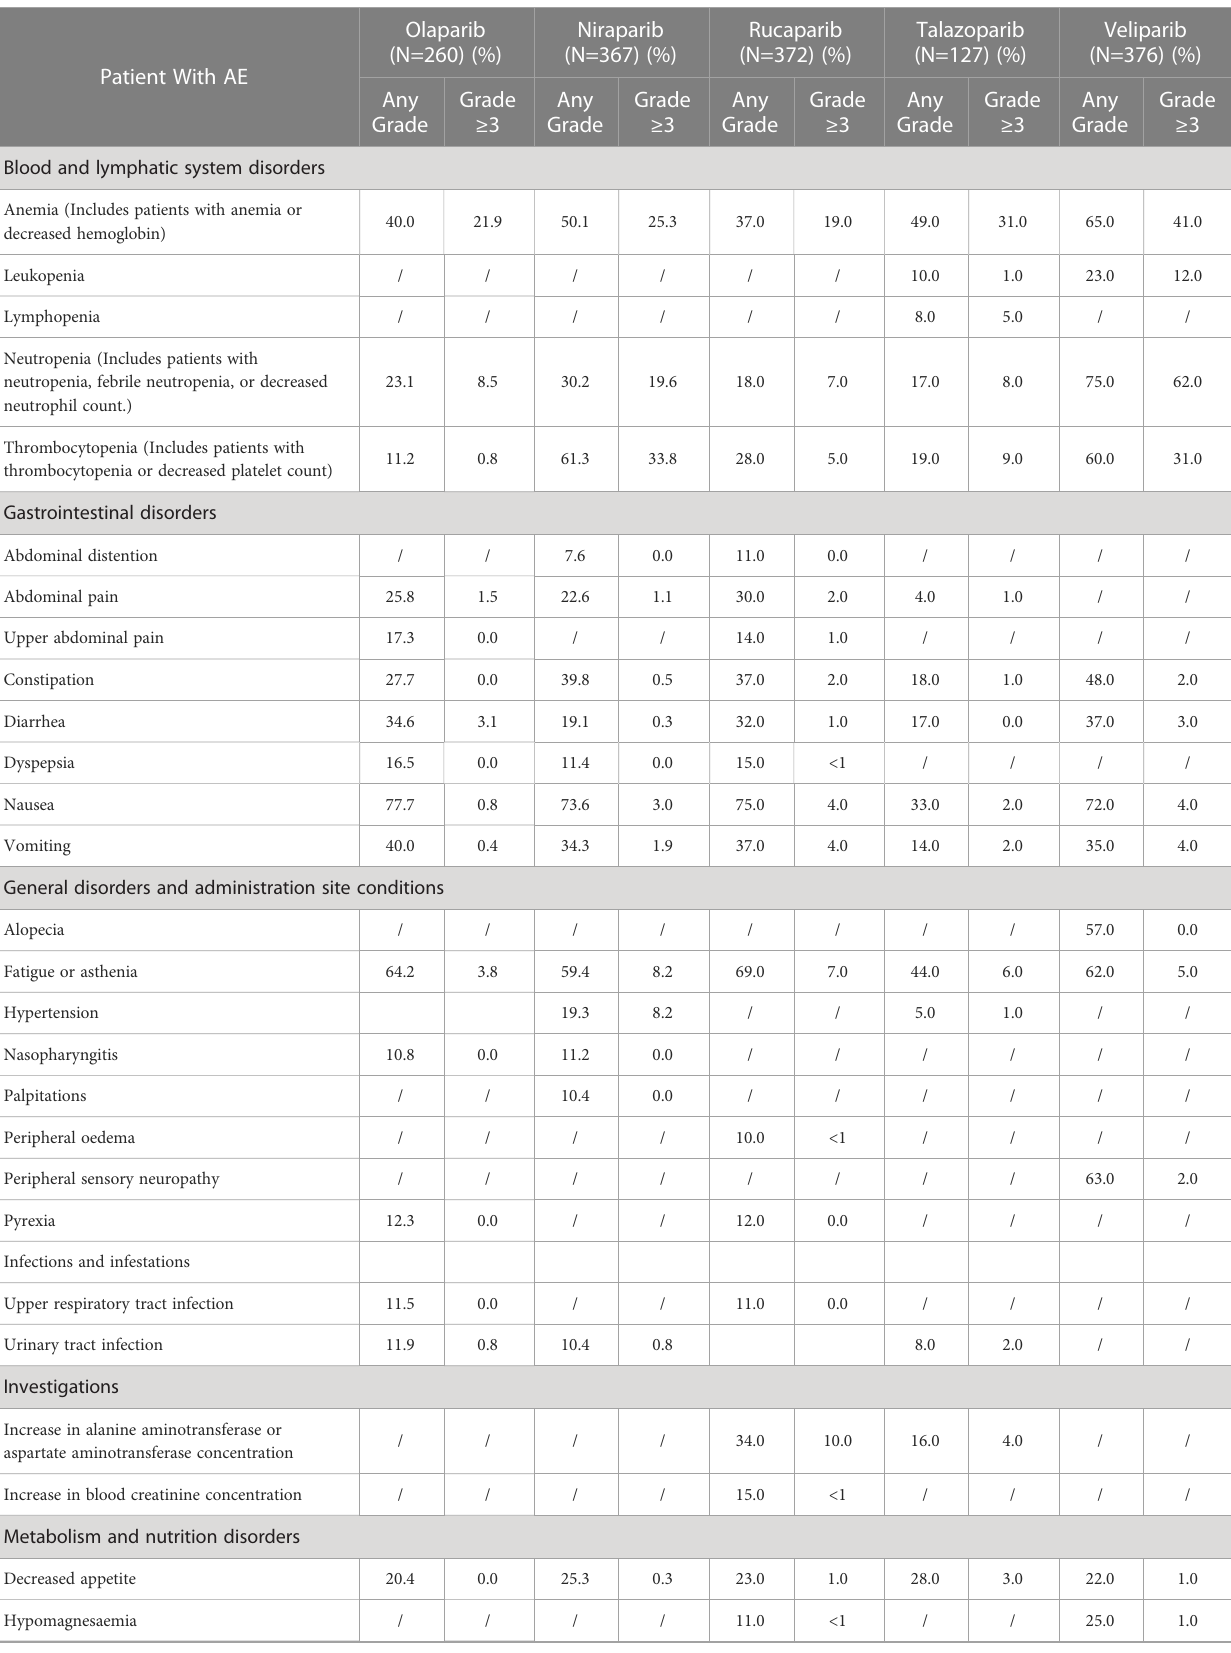
TABLE 1 The most common adverse events and their percentages related to each PARP inhibitor.